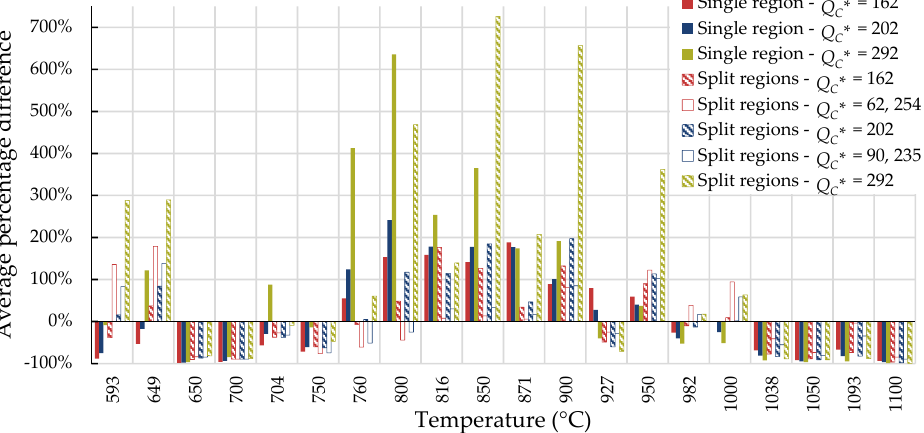
Figure 8. Average percentage difference at each temperature for Inconel 617 using data with times to rupture less than 10,000 h to calculate (cid:1843) (cid:3004)∗ (kJ/mol).